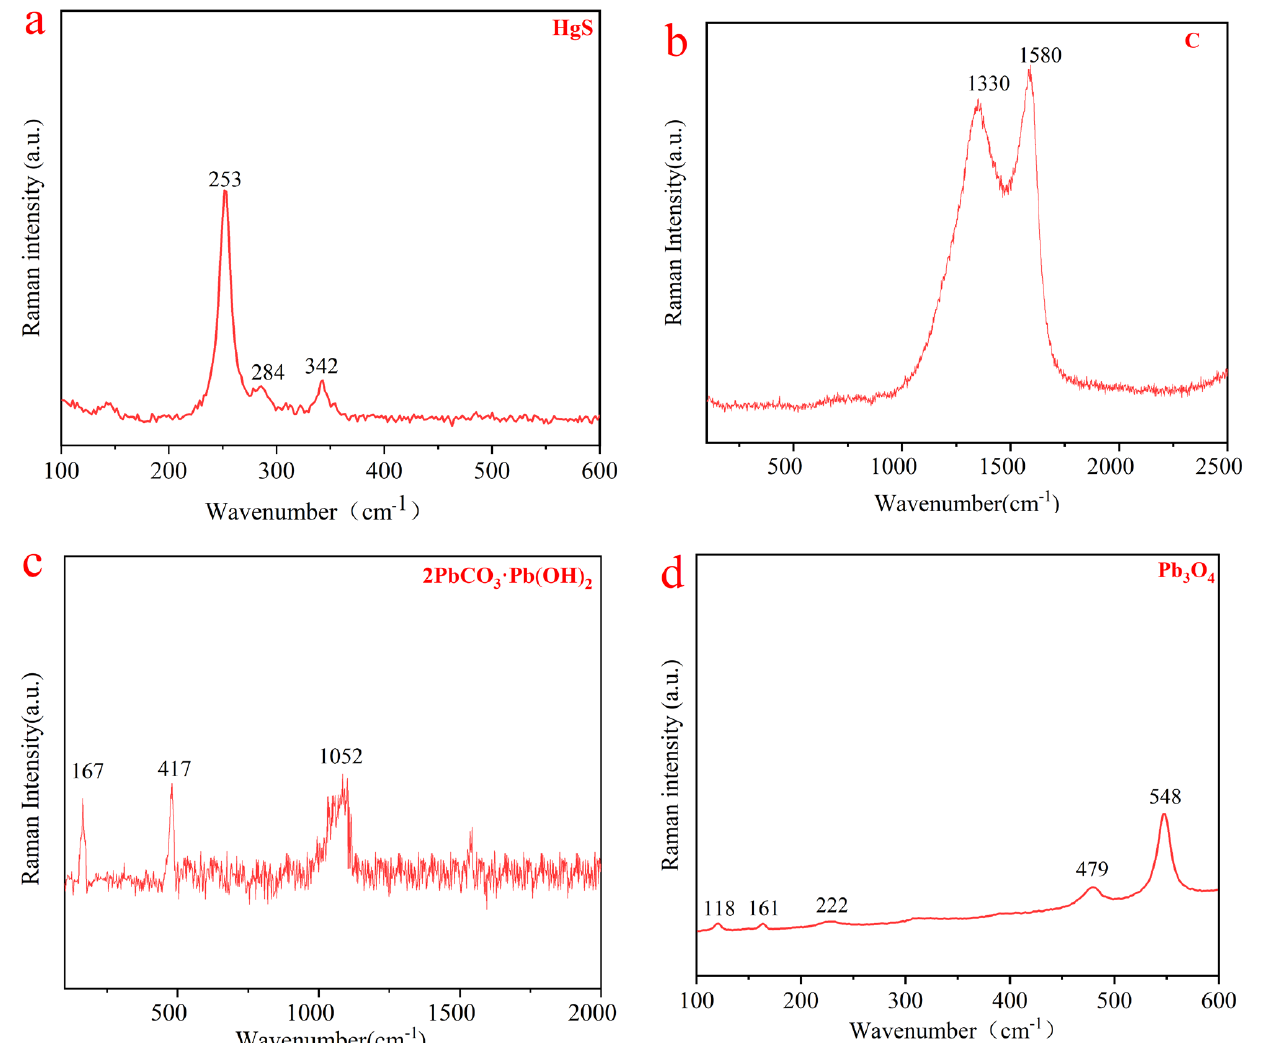
Figure 1. Raman spectra of ( a ) the red-1 pigment (vermilion; HgS); ( b ) the black pigment (carbon black; C); ( c ) the white pigment (lead-white; 2PbCO 3 · Pb(OH) 2 ); ( d ) the red-2 pigment (lead red; Pb 3 O 4 ).